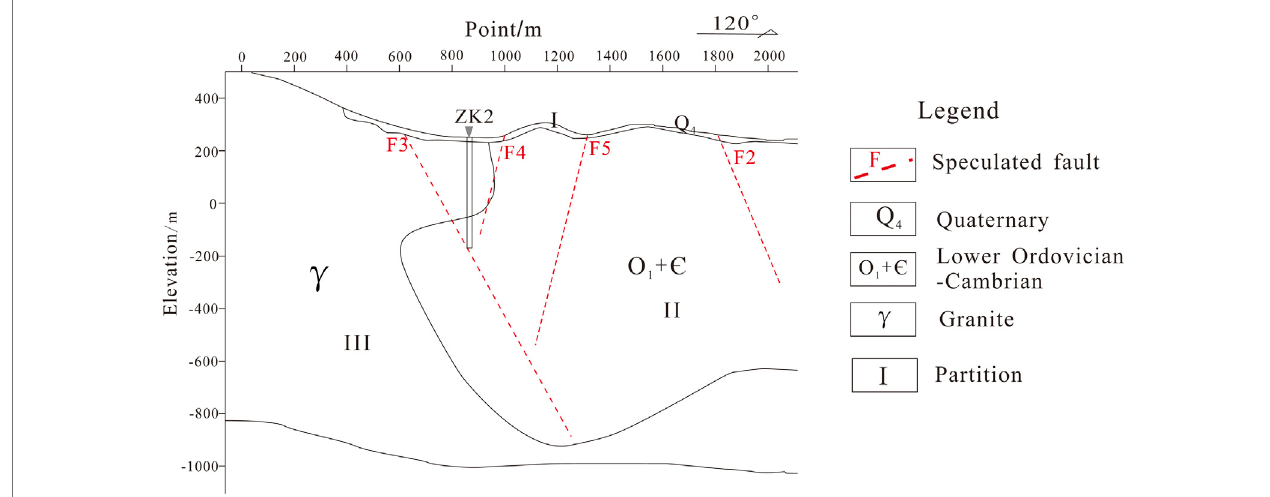
FIGURE 8 | CSAMT integrated interpretation section of survey line L2 and its regions.